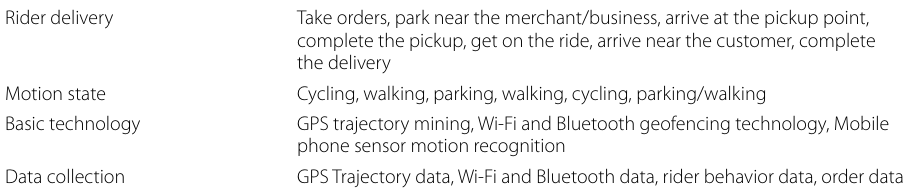
Source: The Practice of Machine Learning in Meituan’s Distribution System: Using Technology to Restore the Real World, 2019 (https:// tech. meitu an. com/ 2018/ 12/ 13/ machi ne‑ learn ing‑ in‑ distr ibuti on‑ pract ice. html)